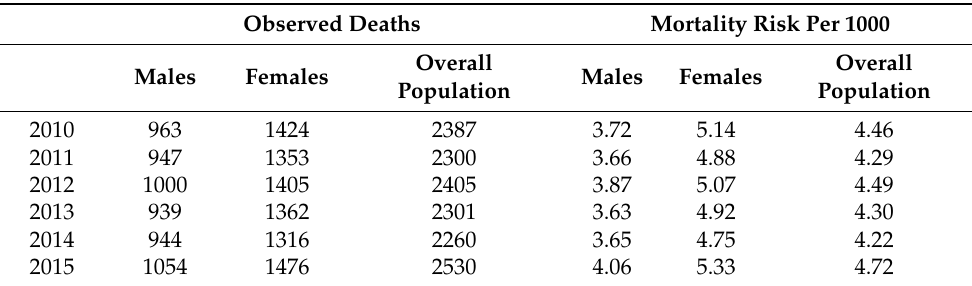
Table 2. Summaries of observed cardiovascular deaths and crude mortality rate in each year of the study period by gender.